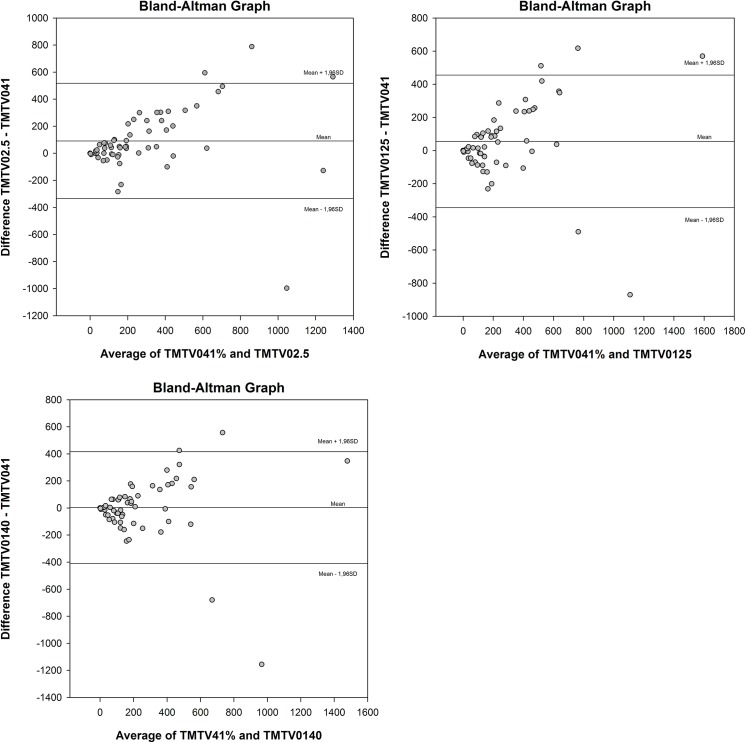
Bland Altman analysis of different TMTV0 methodologies.Bland-Atman analysis comparing TMTV0 values of TMTV02.5 (a), TMTV0125 (b) and TMTV0140 (c) to TMTV041. Mean bias and limits of agreements are represented by solid lines.